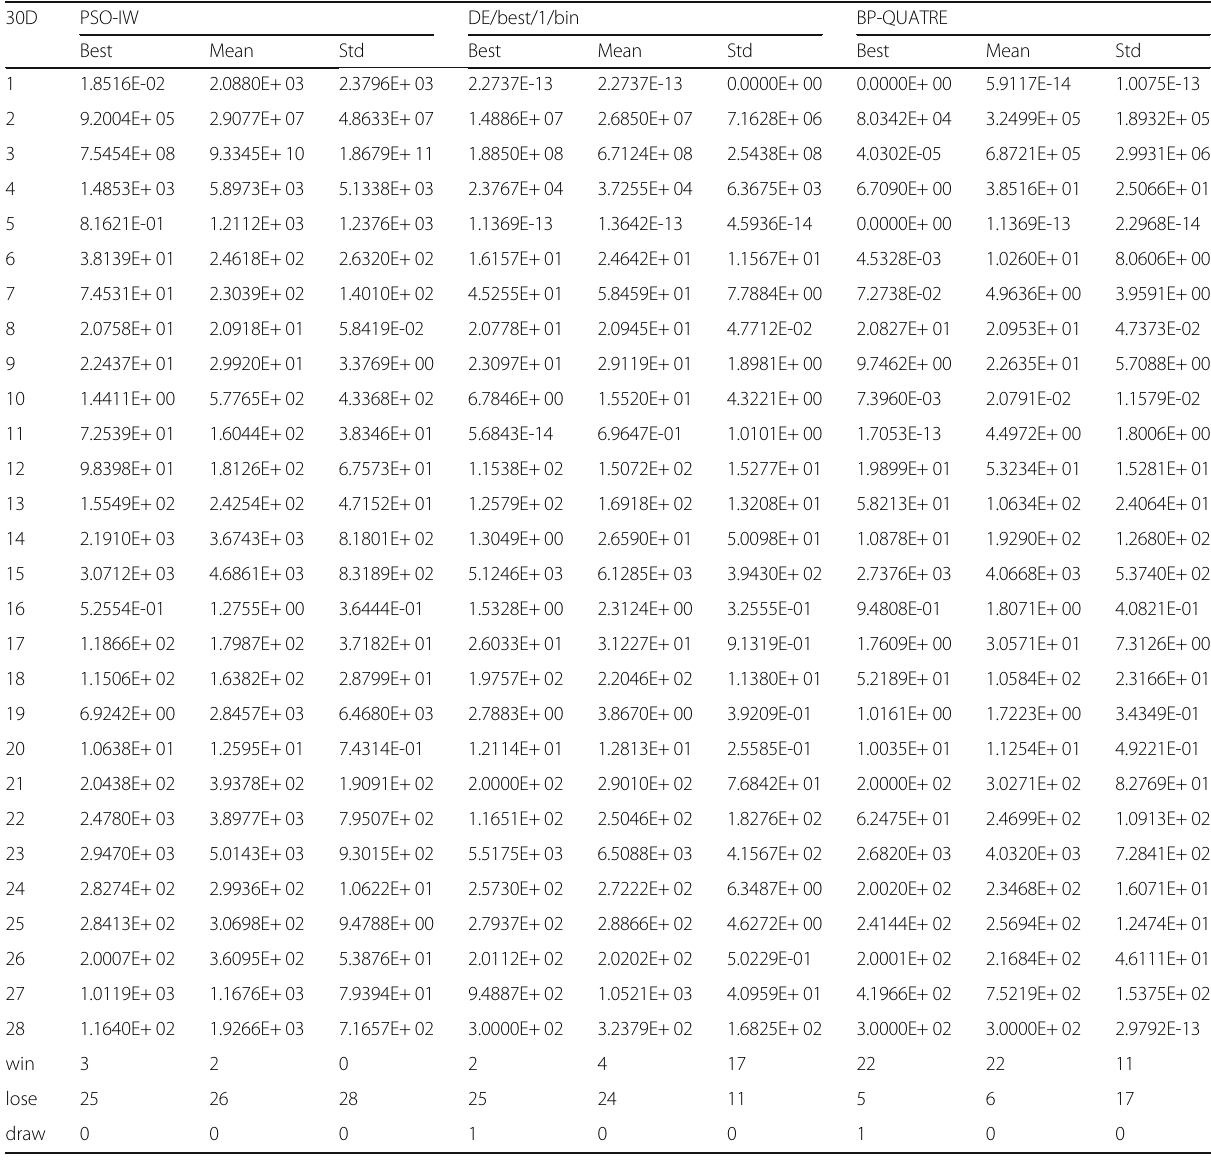
Table 3 Performance for BP-QUATRE, PSO-IW, and DE